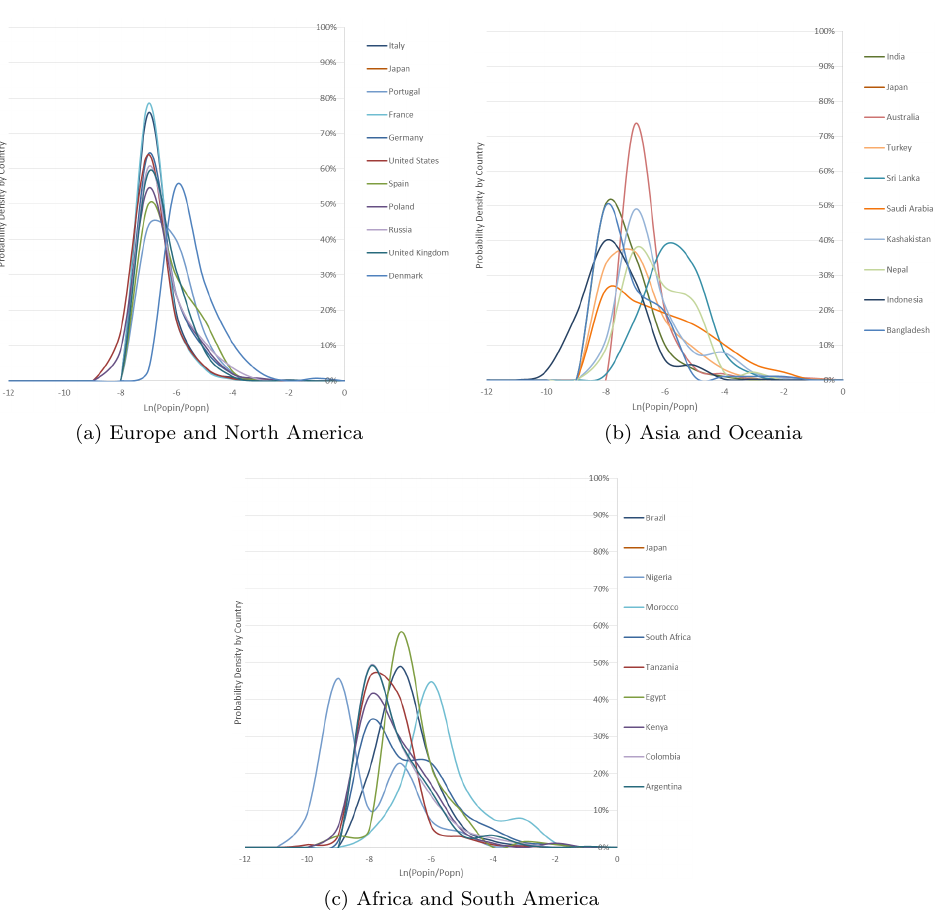
Figure 2: Kernel Density of the Logarithm of the Relative Size of the Cities by Country population of the country ( Pop ) obtaining the weight of each city in the total population of the country. Then the coefficient of the Zipf curves by Country ( µ ) (Figure 1) was estimated regressing the logarithm of the weight of the city population with the logarithm of the rank order of the city (Equation